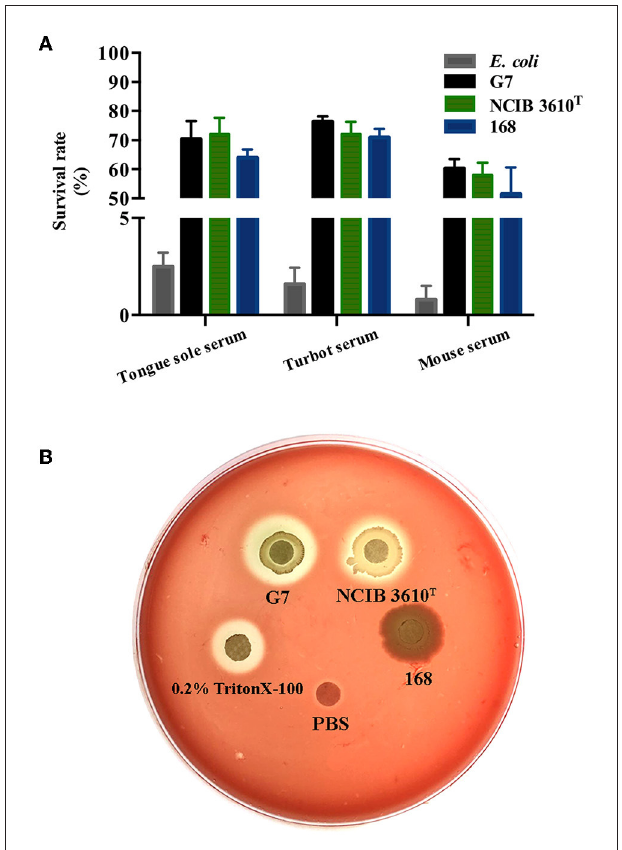
FIGURE 8 | Serum resistance (A) and hemolytic activity (B) of G7. (A) G7, NCIB 3610 T , strain 168, and Escherichia coli were incubated with or without (control) serum from tongue sole, turbot, or mouse, and bacterial survival was determined by plate count. The survival rate was expressed as (number of cells surviving serum treatment/number of cells in control treatment) × 100%. The data are the means of three experiments and shown as means ± SEM. (B) G7, NCIB 3610 T , strain 168, 0.2% Triton X-100, and PBS were spotted onto the filter discs in rabbit blood agar plate, and the plate was observed for hemolytic halo after 24h